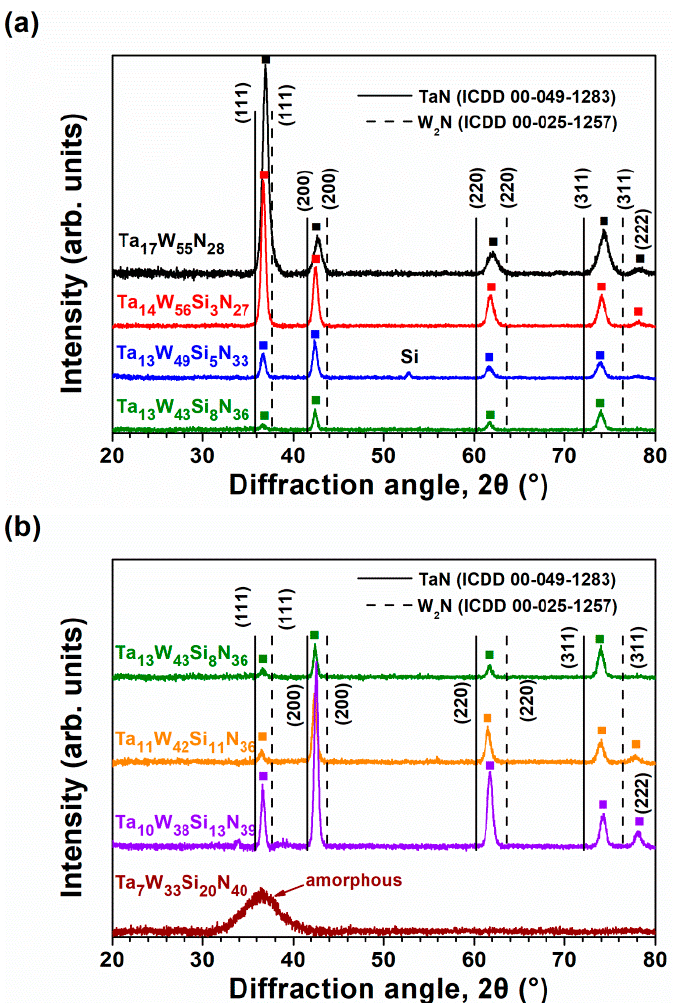
Figure 3. GIXRD patterns of ( a ) Batch S and ( b ) Batch T TaWSiN films.